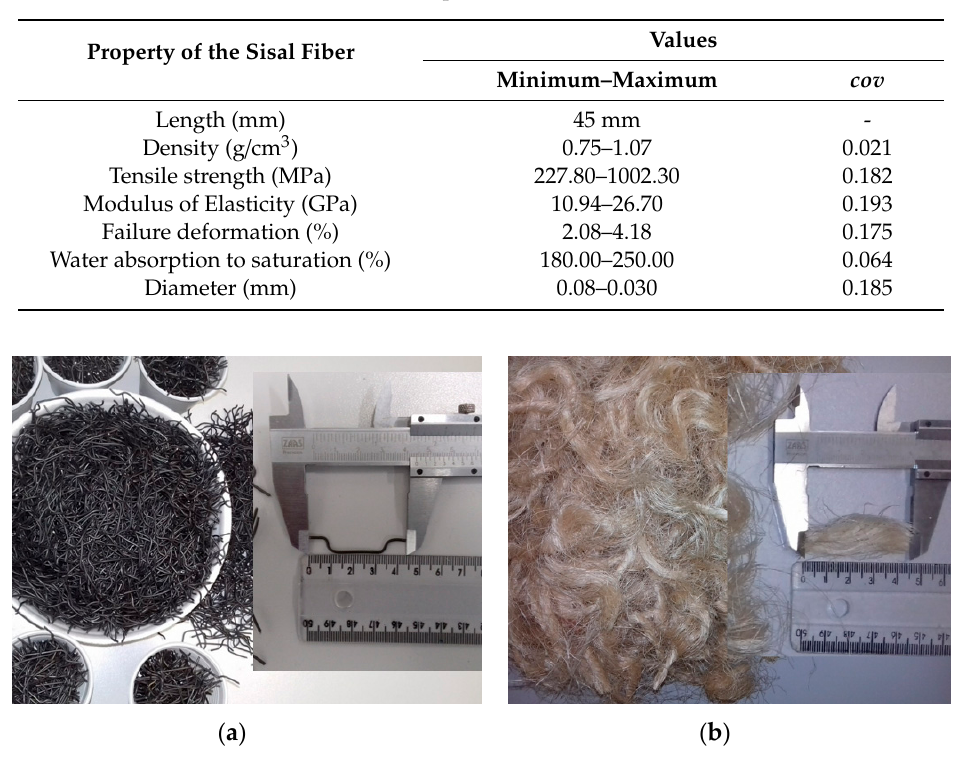
Figure 9. ( a ) Hooked-end steel fibers, ( b ) sisal fibers.